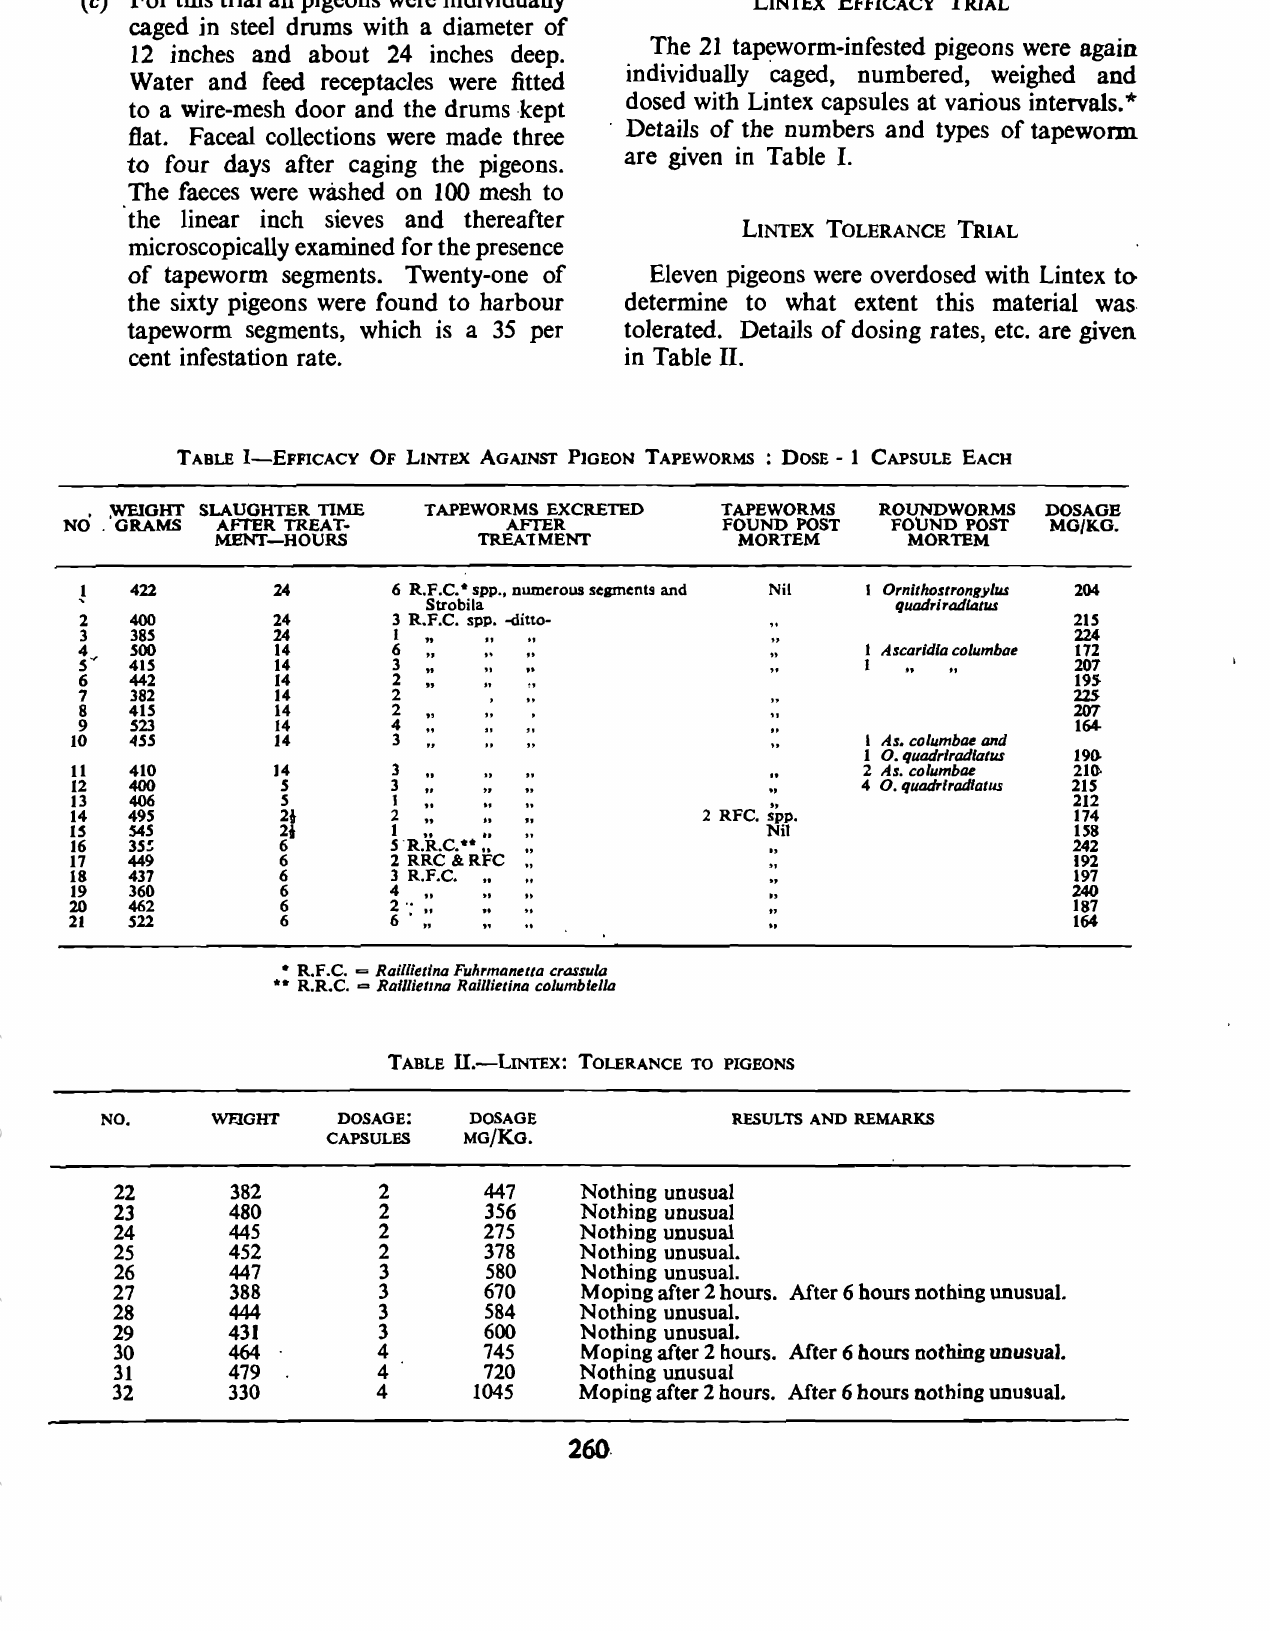
TABLE I-EFFICACY OF LINTEX AGAINST PIGEON TAPEWORMS : DOSE - 1 CAPSULE EACH